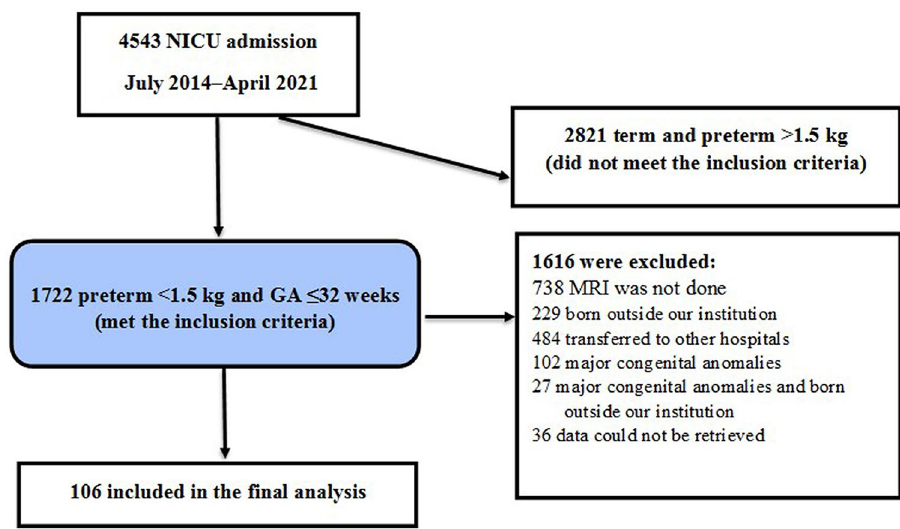
Figure 1. Flow chart of patient selection. GA gestational age, NICU neonatal intensive care